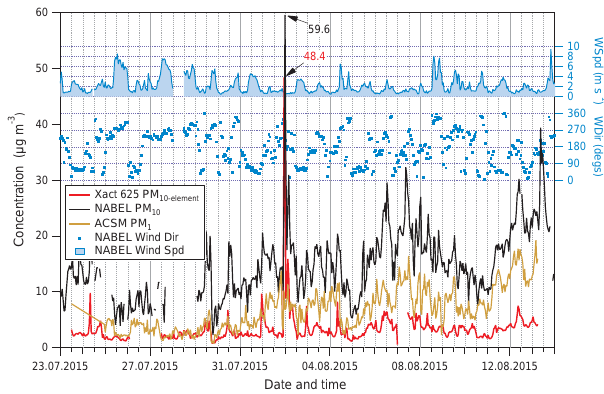
Figure 4. Time series of Xact 625 total elemental concentration, ACSM PM1 data, NABEL TEOM PM 10 data, and wind speed (WSpd) and direction (WDir) measurements in Härkingen. Num- bers at the peaks indicate 1h concentration maxima.